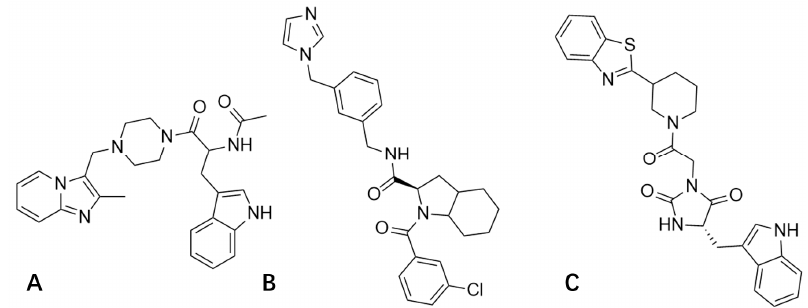
Figure 4. Compound 3206 ( A ); Compound 4808 ( B ); and Compound 15144 ( C